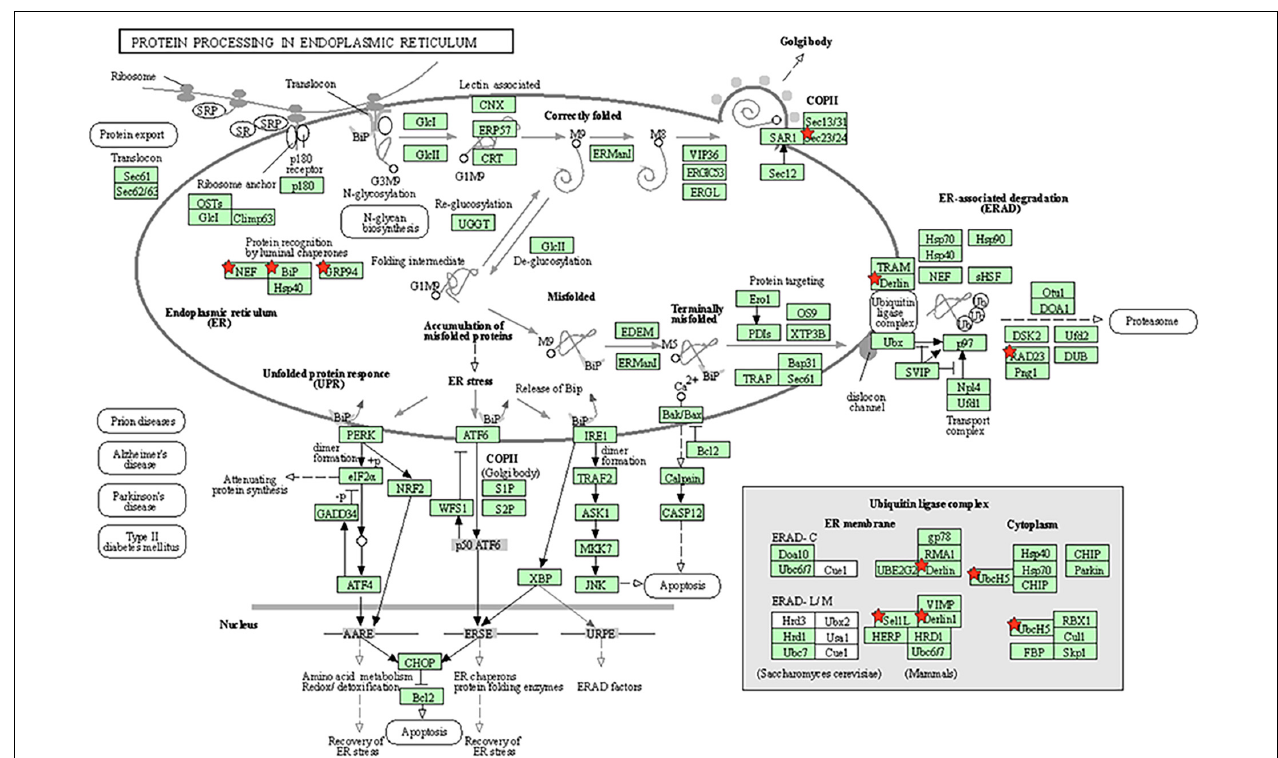
FIGURE 5 | Molecular pathway of endoplasmic reticulum chaperone complex involved in ubiquitin-dependent protein catabolic process. Genes marked the little red pentagram were genes regulated by miR-181a. Figure was cited from DAVID online